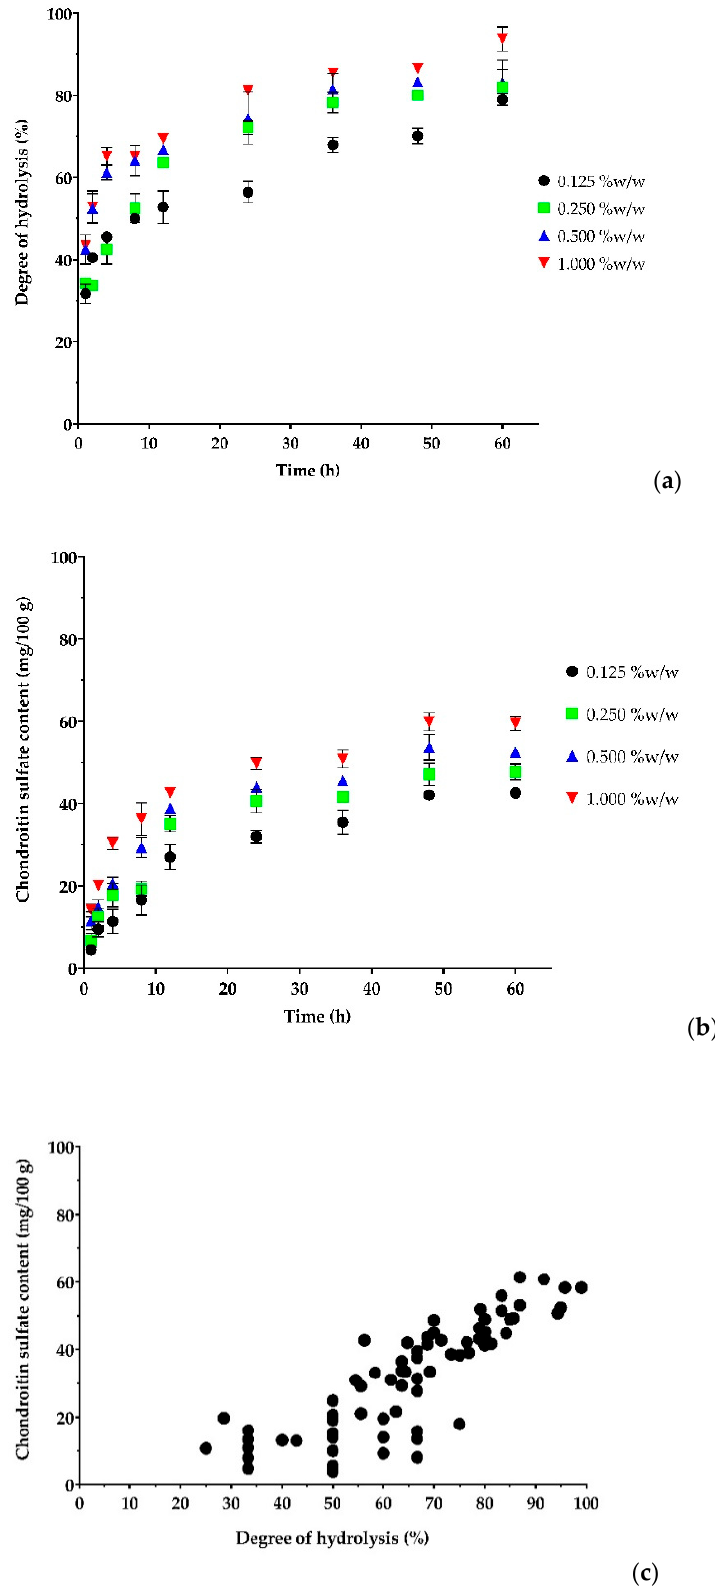
Figure 2. The effects of enzyme concentration and reaction time on ( a ) degree of hydrolysis; ( b ) chondroitin sulfate (CS) content; ( c ) Pearson’s correlation coefficient between the degree of hydrolysis and CS content (r = 0.844, p < 0.01).